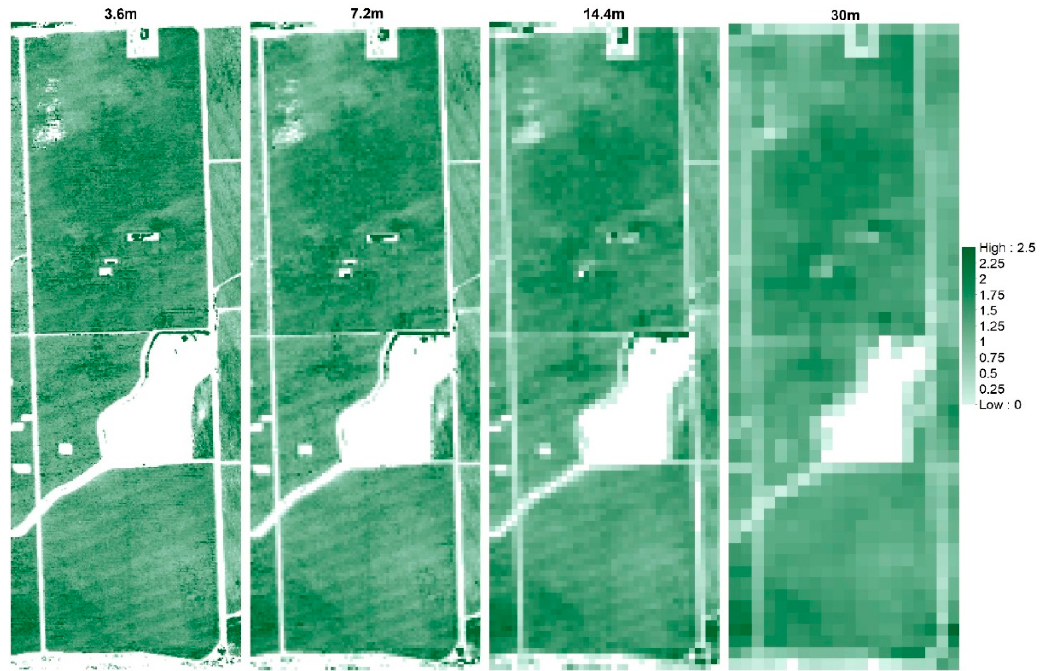
Remote Sens. 2019 , 11 , x FOR PEER REVIEW Figure A3. Example of Modeled w c / h c different spatial domains for 09 August 2014. Figure A3. Example of Modeled w c / h c di ff erent spatial domains for 09 August 2014.